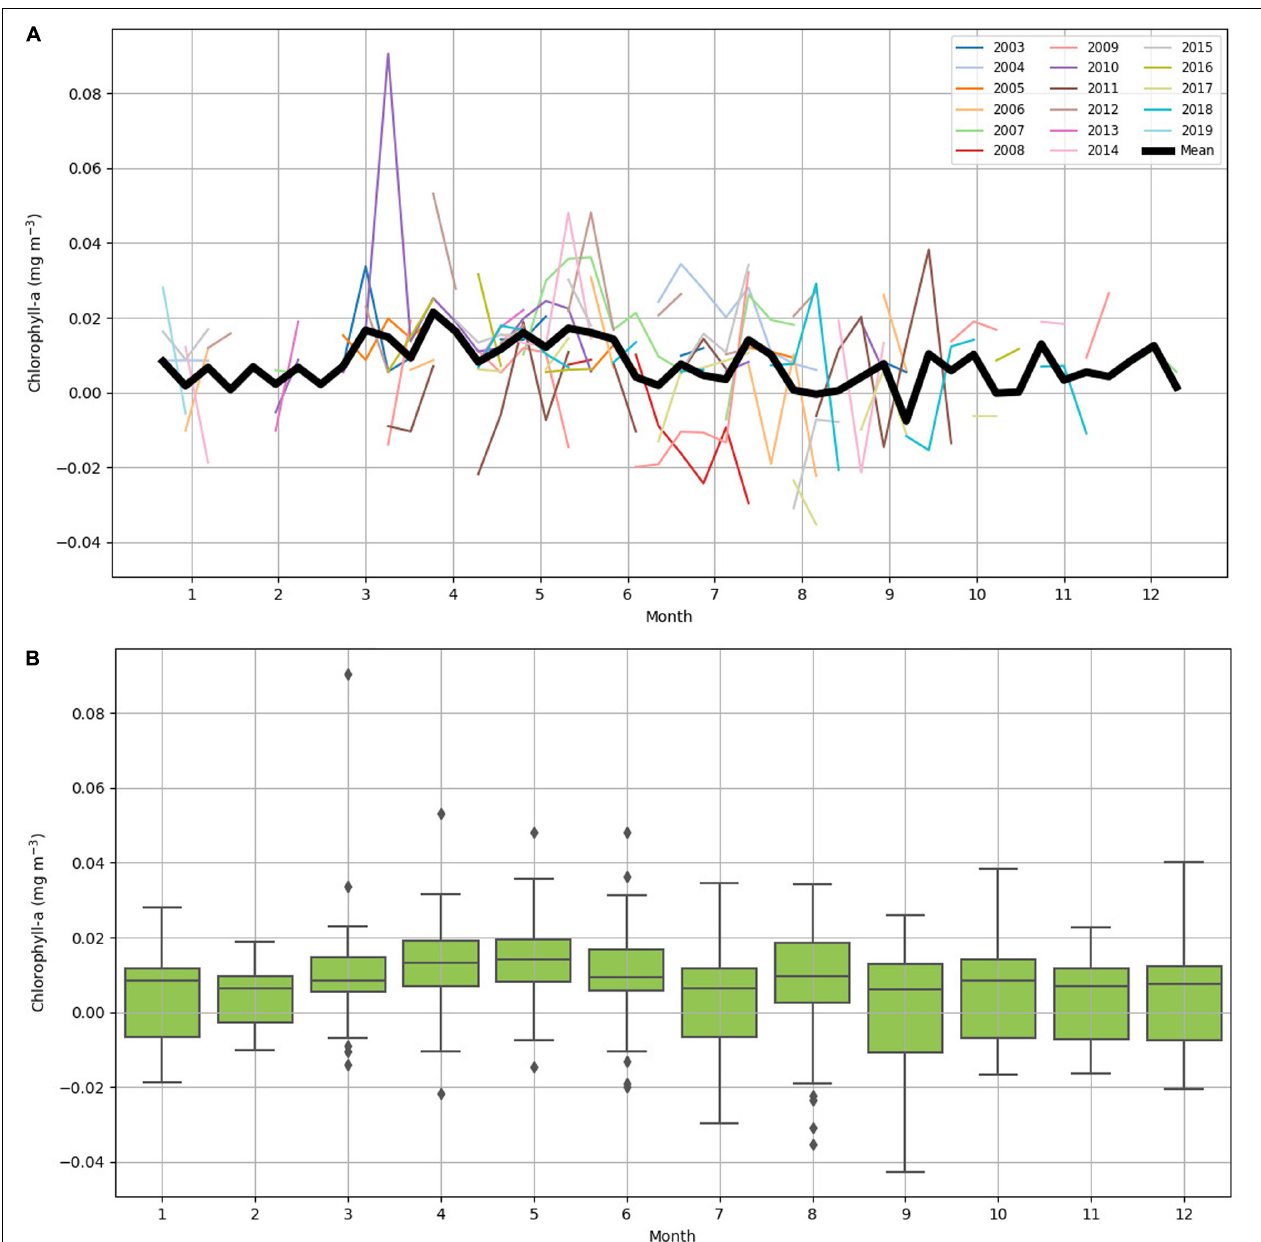
FIGURE 4 | (A) Yearly 8-day mean of chlorophyll-a difference from January 2003 to February 2019. Each year has a color-coordinated line. The dark black line is the collective mean for all years. (B) Box plot of 8-day average chlorophyll-a difference between near Tiputa Channel and offshore by month, derived from data between January 2003 and February 2019. The central mark in each box is the median, the bottom and top edges of the box are the 25th and 75th percentiles. Diamonds indicate